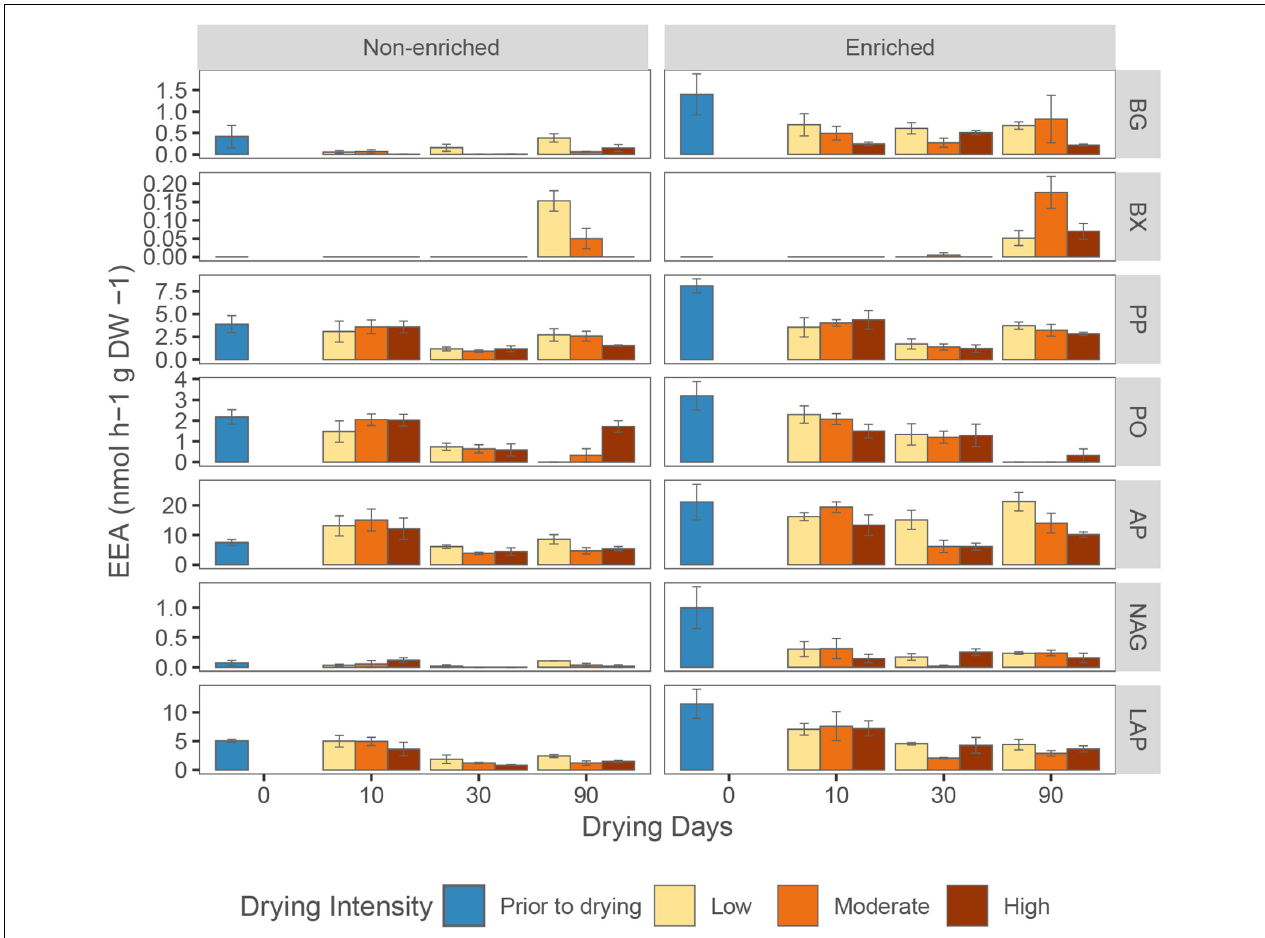
FIGURE 6 | Average (mean + SE, n = 3) sediments extracellular enzymatic activities (EEA) for β -glucosidase ( BG ), β -xylosidase ( BX ), phenol peroxidase (PP) , phenol oxidase ( PO ), alkaline phosphatase ( AP ), chitinase ( NAG ), and leucine aminopeptidase ( LAP ) under various drying intensities (low, moderate, and high) at different drying days (0, 10, 30, and